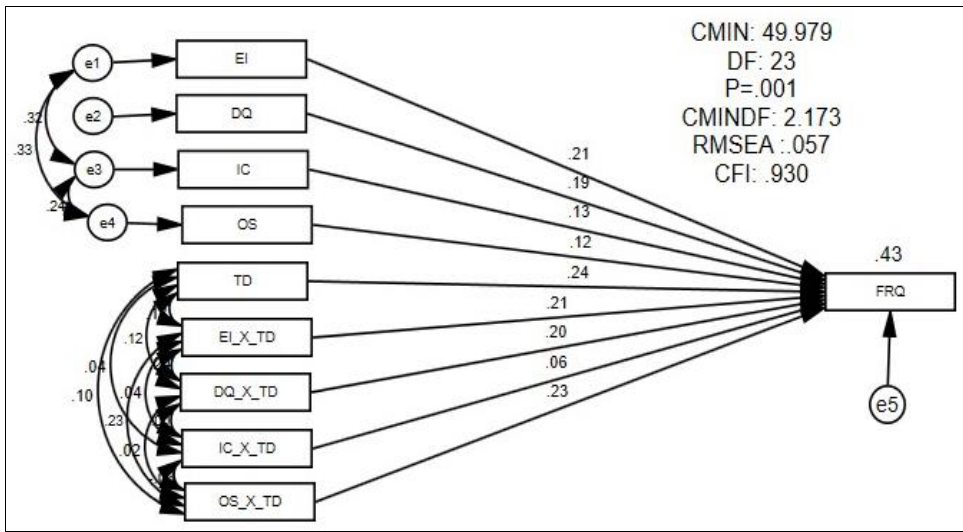
Figure 5. The moderating factor of transparency and disclosure.